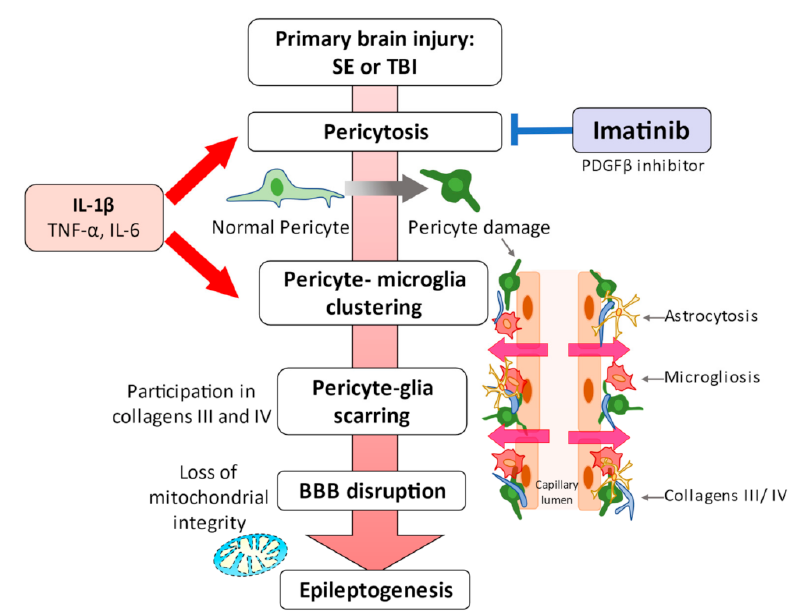
Figure 3. Schematic representation of the events linking pericytes to epilepsy. Status epilepticus leads to redistribution and remodeling of cerebrovascular pericytes, potentially contributing to blood–brain barrier permeability [2,28,29]. A significant clustering of microglia/macrophages around pericytes occurs one week after the attack, although pericyte proliferation is significantly increased as early as 72 h [29]. These series of pericyte-related modifications are promoted by proinflammatory cytokines, including IL-1 β , TNF α , and IL-6. Alterations caused by IL-1 β , which is one of the cytokines most deeply involved in the pathogenesis of epilepsy, were most pronounced. These pericyte-associated modifications and pericyte-microglia clustering may be facilitated by IL-1 β [29], and pericyte-glial scarring with collagens III and IV process leaky capillaries during seizure progression [30]. Recurrent arterial and capillary levels. Moreover, capillary vasoconstriction is accompanied by a loss